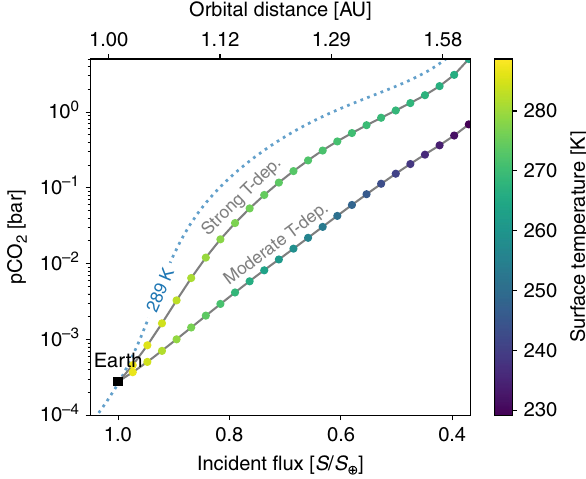
Fig. 2 The relationship between incident fl ux and atmospheric CO 2 for Earth-like planets regulated by a carbonate – silicate weathering cycle. The horizontal axis shows incident fl ux, S , normalized to the solar constant ( S ⊕ ) and the corresponding orbital distance in Astronomical Units (AU) above the plot. The vertical axis shows the atmospheric CO 2 partial pressure (pCO 2 ) in bar. The dotted blue curve labeled 289 K shows the pCO 2 value required to maintain a 289 K surface temperature for the given incident fl ux, S . The conventional assumption of CO 2 in the HZ stipulates that pCO 2 will adjust to maintain a temperate or even constant surface temperature. Under this assumption, moving the modern Earth (labeled black square) outward in the HZ would have the planet approximately follow the dotted blue 289K contour. The colored points and gray curves show the modern Earth moving outward in the HZ with a functioning carbonate – silicate weathering cycle, calculated from Eq. (6). We consider two temperature and pCO 2 dependencies for continental weathering in this plot. The strong temperature dependence contour (labeled Strong T-dep.), uses a temperature and pCO 2 -dependent weathering factor of α T e = 2.3, which implies a strong temperature feedback on continental weathering compared to the pCO 2 feedback (see Eq. (7)). The moderate temperature dependence contour (labeled Moderate T-dep.), uses a temperature and pCO 2 -dependent weathering factor of α T e = 7.5. These two values for α T e result in two different paths the Earth can take as it moves outward in the HZ. The planet color shows the mean surface temperature. Log-linear fi ts to the colored points of the Strong T-dep. and Moderate T-dep. contours have r 2 values of 0.959 and 0.999, respectively. Thus, even for a strong temperature dependence of continental weathering, our coupled climate and weathering model predicts an approximately log-linear relationship between incident fl ux and pCO 2 on Earth-like planets in the HZ.